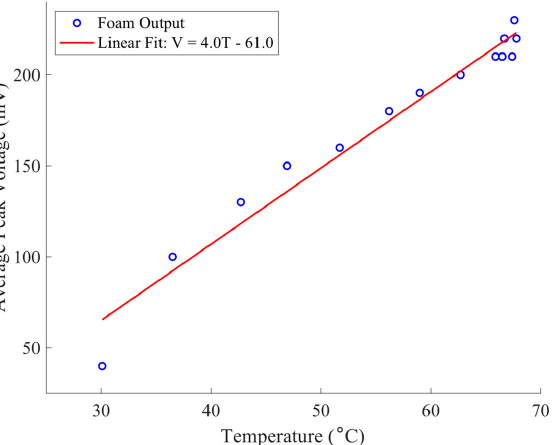
Figure 8. Average peak voltage versus temperature over 130 s for 45 Hz cyclical compression.